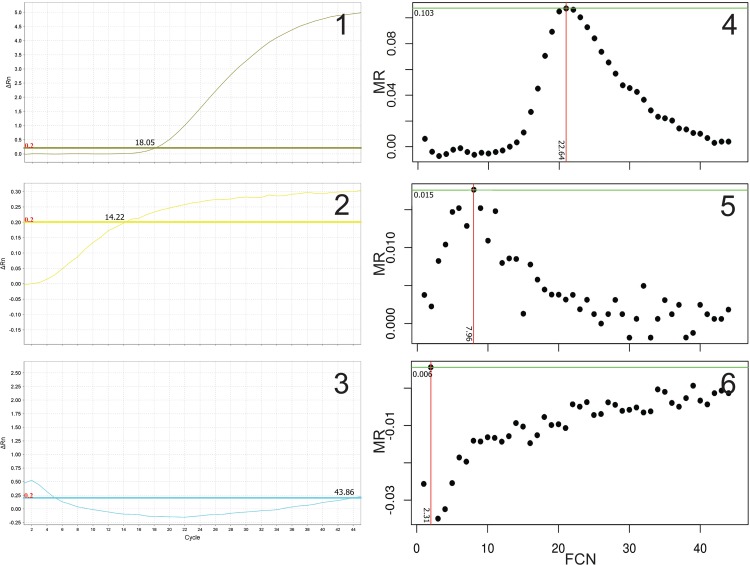
Examples of amplification profiles and MR responses.Representative amplification profiles of typical cases observed in this study. Sigmoid profile derived from a clear positive sample observed with the CT method (1) and the associated Gaussian profile of the MR response (4). Low fluorescence signal that crossed the threshold level giving a positive result with a low Cq value using the CT (2) but not with the MR (5) method. Transient peaks in fluorescence resulted in high Cq value with the CT method (3) but gave a negative result using the MR method (6). The y-axis is provided in different scales across the panels.